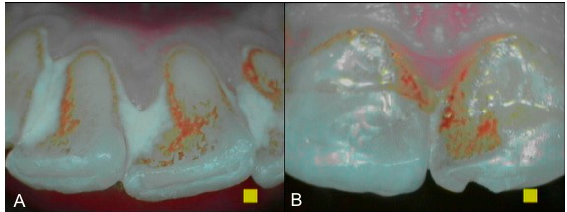
Figure 3. ( A , B ). Intraoral camera Soprocare images of calculus on lower and upper incisors.